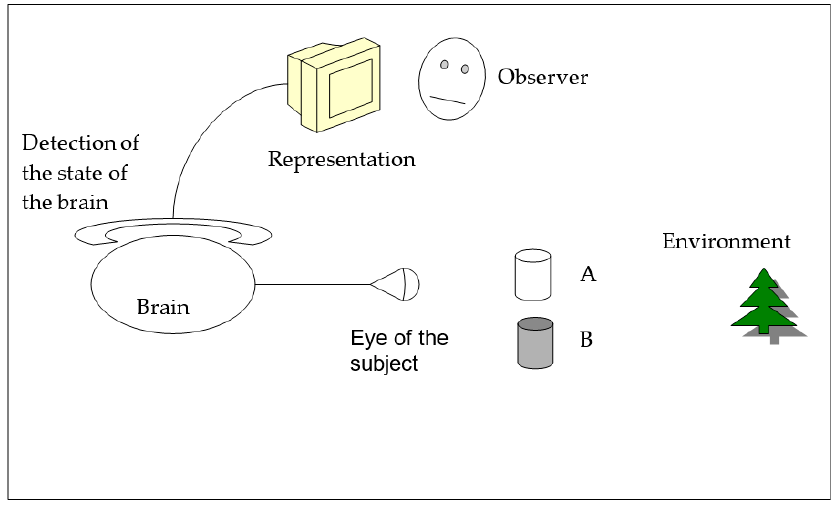
Figure 1. A system consisting of a human who has to decide whether to drink a cup of pure water (A) or one of wine (B). Only the brain and eye of the human being is sketched. The brain of the human is fully detected; its state of being is represented on a screen. If the way the human brain works is predetermined, the observer will know in advance if the human will choose possibility A or B.